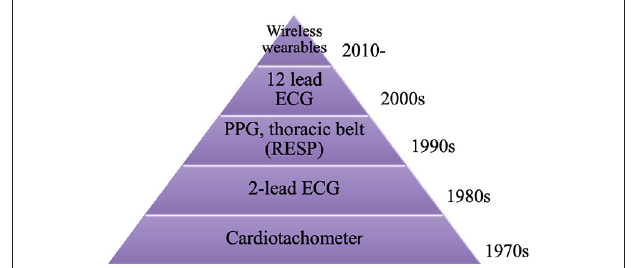
FIGURE 3 | Evolution of feature analysis for HRV from 1940 to 2020.